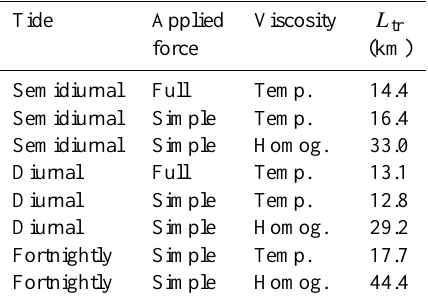
Table 6. Summary of the L tr for the viscoelastic models. Viscosity models are either homogeneous (homog.) or temperature dependent (temp.). We include homogeneous models only for completeness since we consider the temperature-dependent models to be more physically realistic. The applied force describes the nature of the tidal loading applied in the model, as is described in Appendix C.